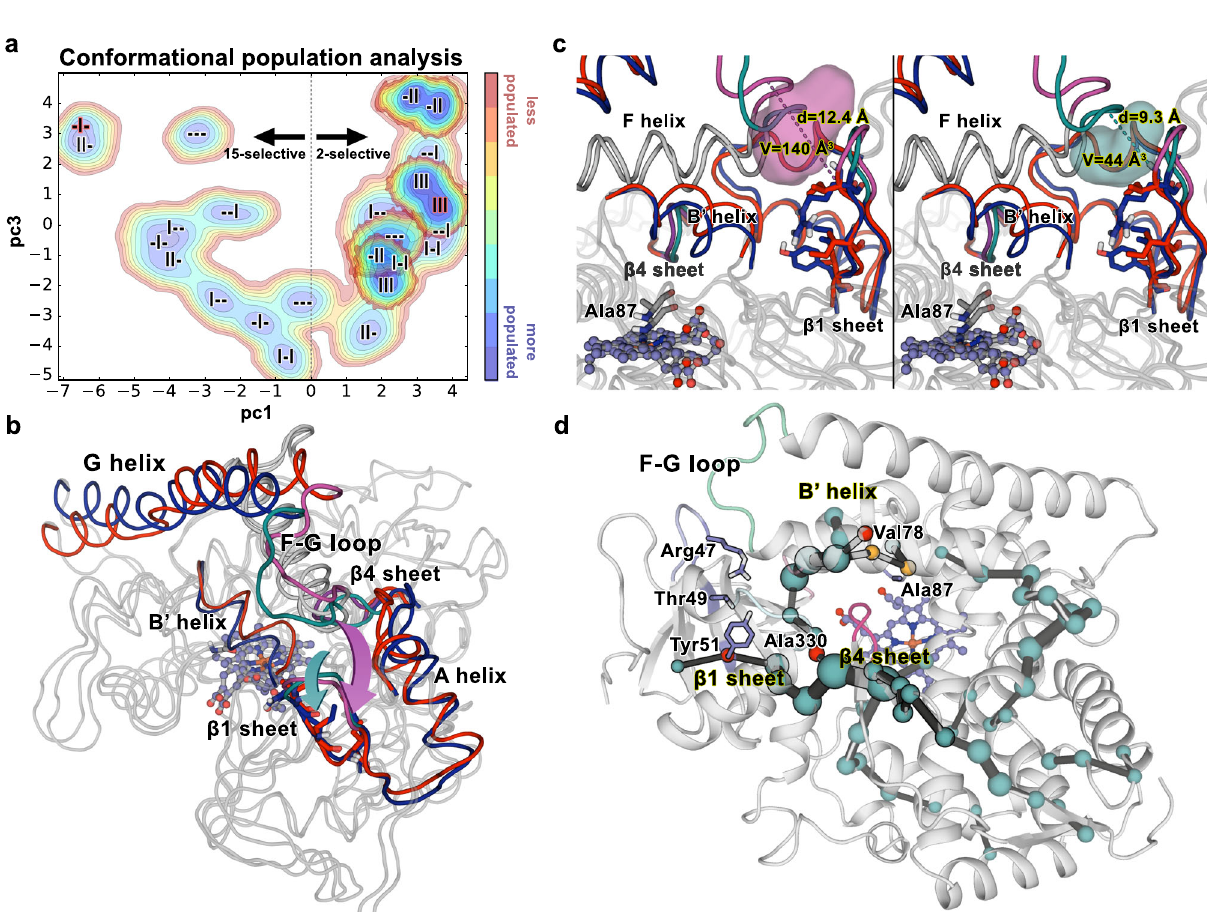
Fig. 7 Analysis of the conformational dynamics of deconvolution mutants. a Conformational population analysis built from the combined PCA of all substrate-free simulations of mutants. The conformational populations of 2 β -selective mutants -II and III are highlighted. All replicas (3/3) of III and -II, 2/3 replica of I-I and --I lie on positive values of pc1 (10 out of 12 replicas of 2 β -selective mutants). All replicas (3/3) of -I-, 2/3 replicas of ---, I-- and II- show negative values of pc1 (9 out of 12 replicas of all 15 β -selective mutants). b Overlay of the conformational changes involved in PC1. c Zoom of b showing the channel 2a cavity of mutant III (left panel) and -I- (right panel). In b , c , Mutant -I- is shown in blue, whereas the evolved mutant III is coloured in red. The F- G loop, β 1 sheet and channel 2a cavity are highlighted in teal and magenta for -I- and III, respectively. d Analysis of the most important correlated motions of mutant --- by means of the shortest path map (SPM). Mutational hotspot used in this or precedent work 41 that appear in the SPM are highlighted with red spheres, whereas positions adjacent to mutational hotspot are highlighted with orange spheres. See Fig. 1d for mutant